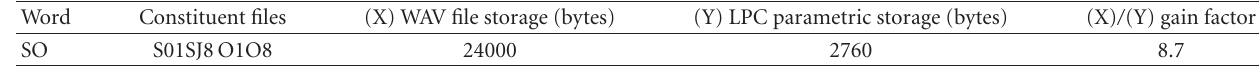
Table 5: Sample comparison of memory for LPC and WAV file